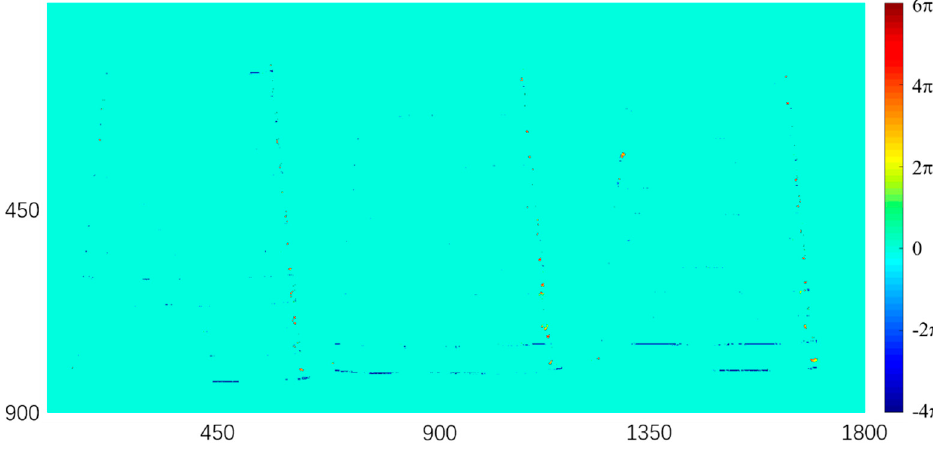
Figure 12. The segmentation error between the output feature map and the ground truth.